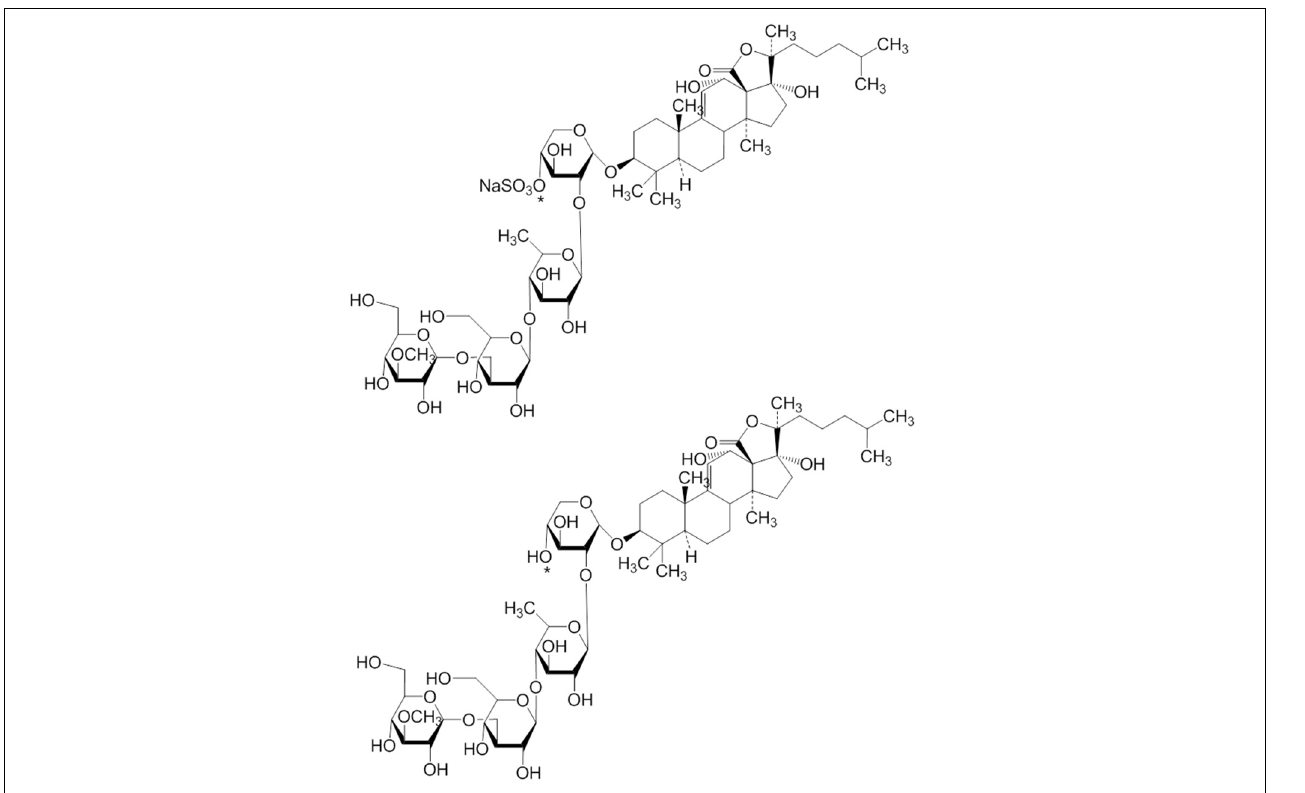
FIGURE 9 | The structures of 20 and 21 are